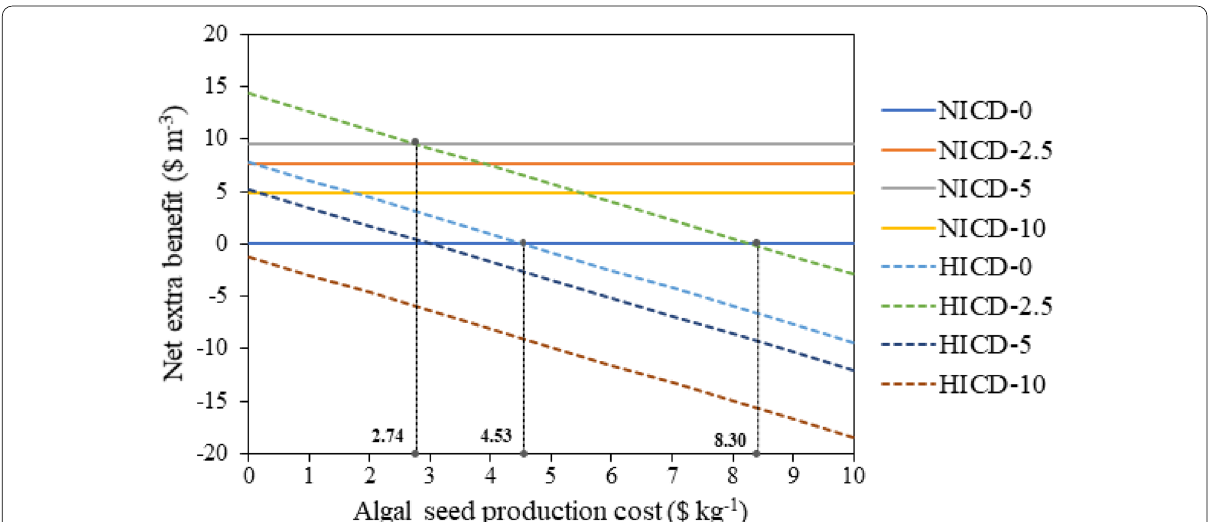
Fig. 7 Modelling of the net extra benefit from GABA supply and ICD increase for starch production under nitrogen deprivation as a function of the algal seed production cost in T.